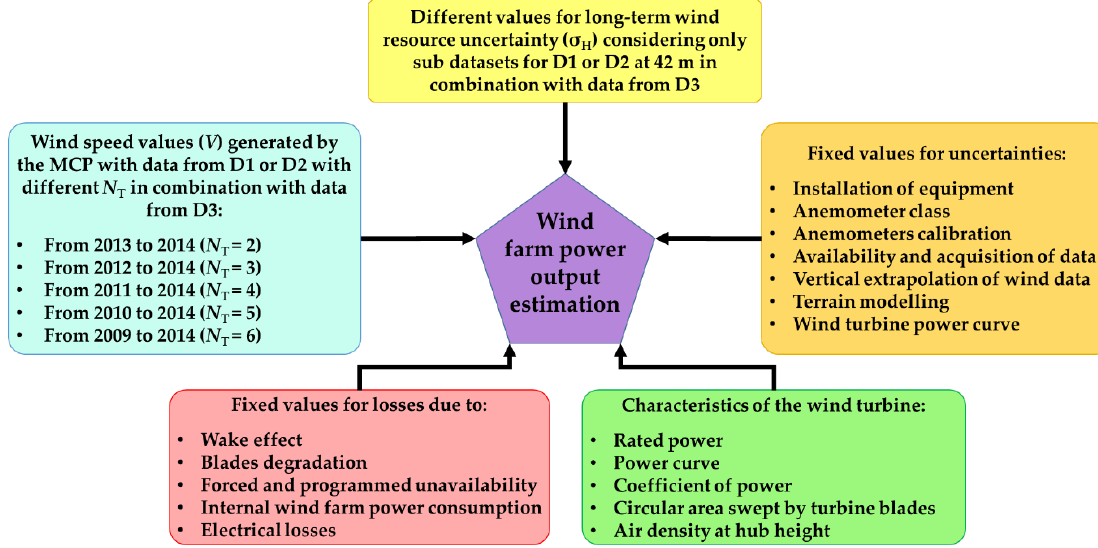
Figure 4. Wind farm power output estimation and all its influence factors.